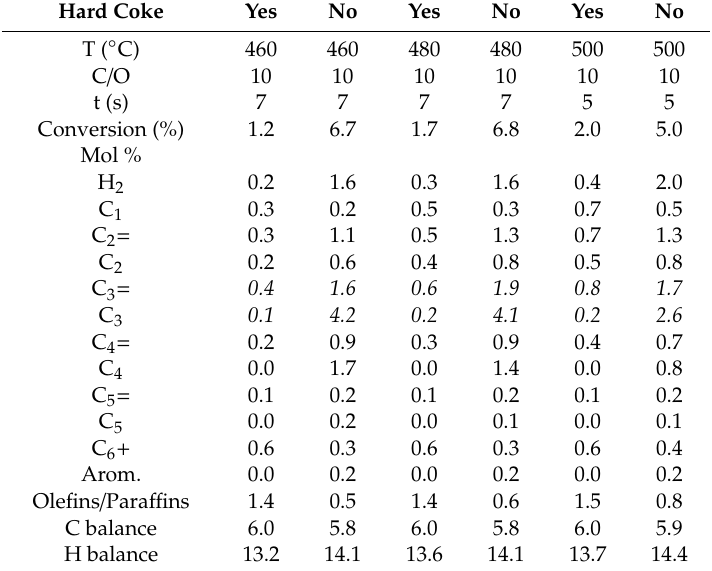
Table 2. Comparison of experimental results from riser simulator recorded with and without “hard coke” at the same conditions.